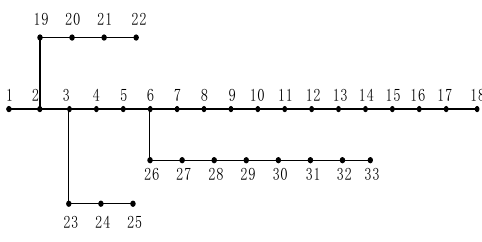
Figure 8. IEEE 33-node power distribution system.